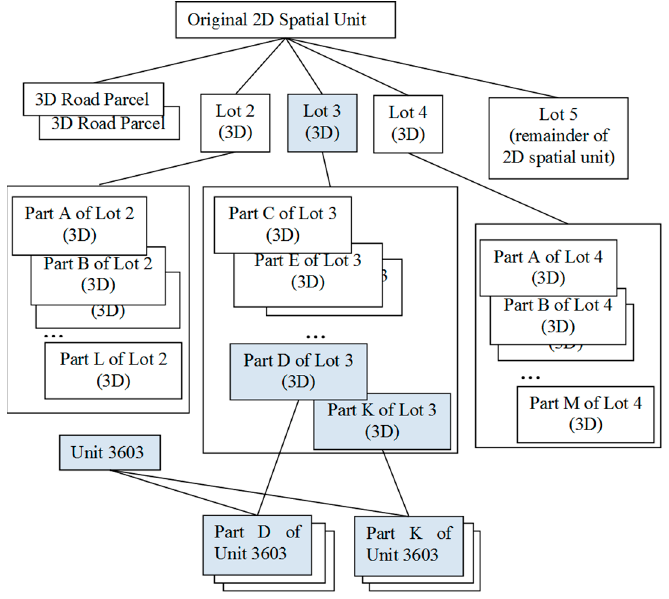
Figure 10. The hierarchy of spatial units and part spatial units, and their use in the definition of basic allocation units.